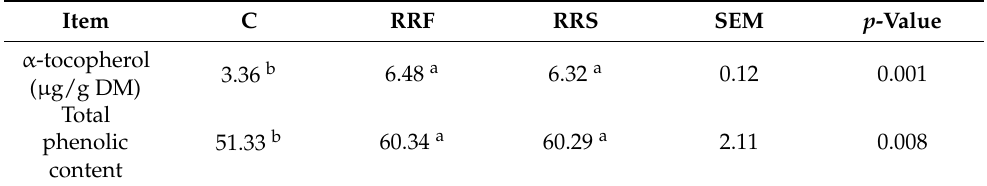
Table 5. Meat vitamin E and total phenolic content in Barbarine lambs fed RR-based